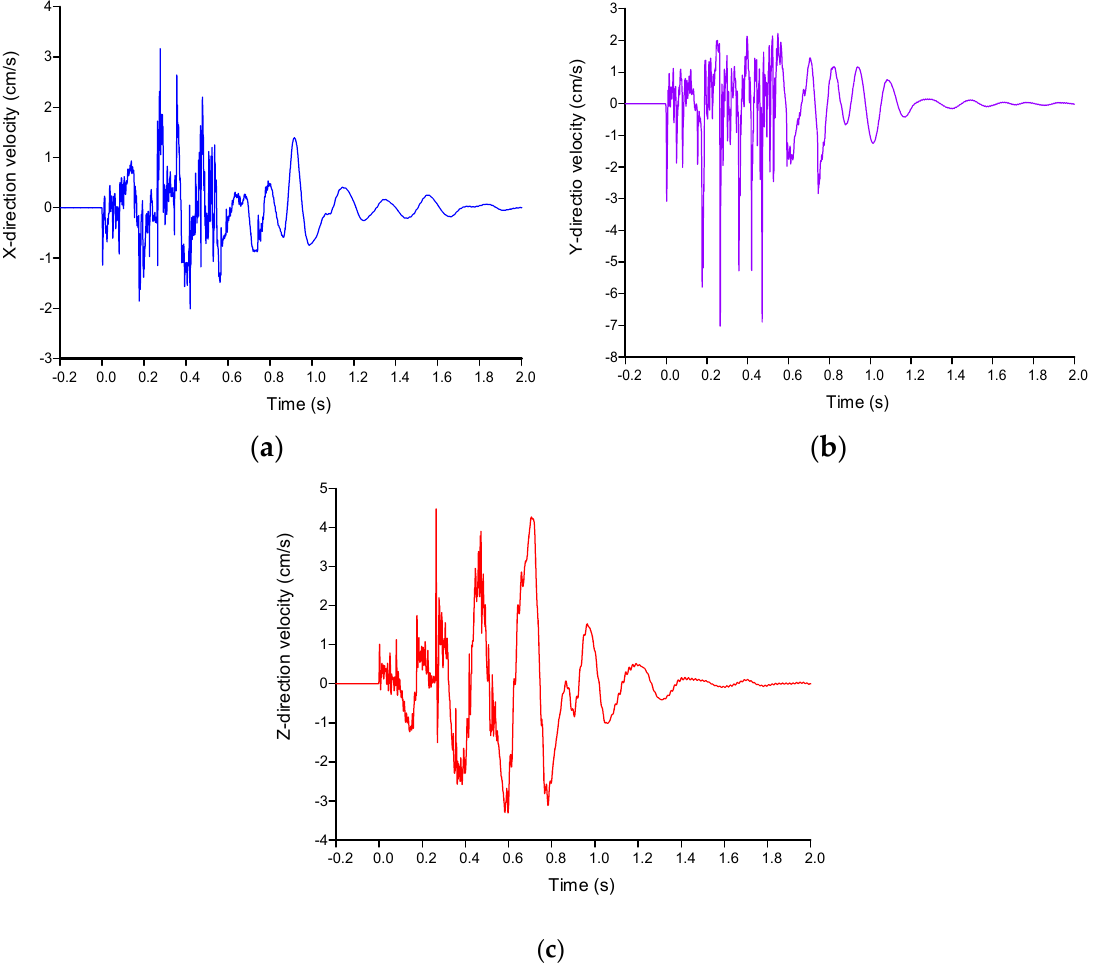
Figure 7. Time history curve of blast vibration of no. 1 monitoring point in region III. ( a ) X-direction velocity, ( b ) Y-direction velocity, ( c ) Z-direction velocity. Table 1. Recorded blast vibration data.